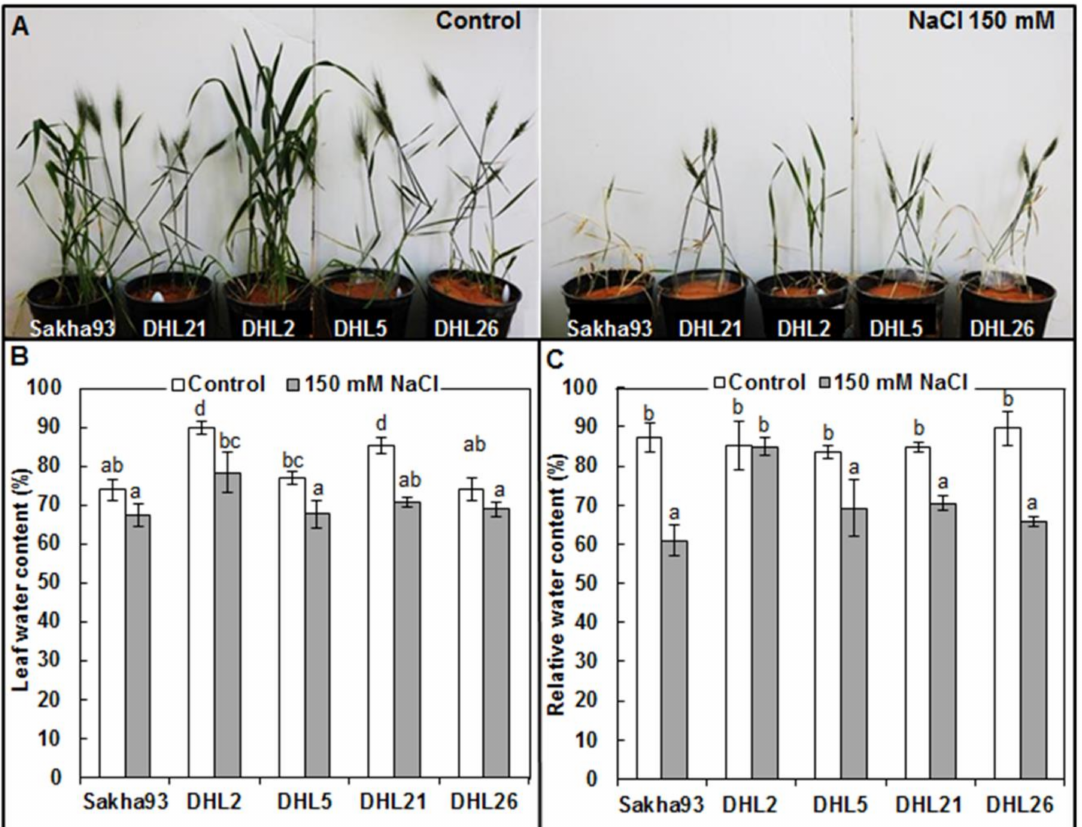
Figure 1. Assessment of salt stress tolerance of five wheat genotypes. ( A ) Phenotype of the five wheat genotypes at the floret initiation stage grown under normal and salt stress conditions. ( B ) Leaf water content. ( C ) Relative water content. Values are presented as the mean ± SE of at least three replications, and values sharing the same letter for each treatment × genotype combination are not significantly different ( p ≤ 0.05) according to Duncan’s multiple range